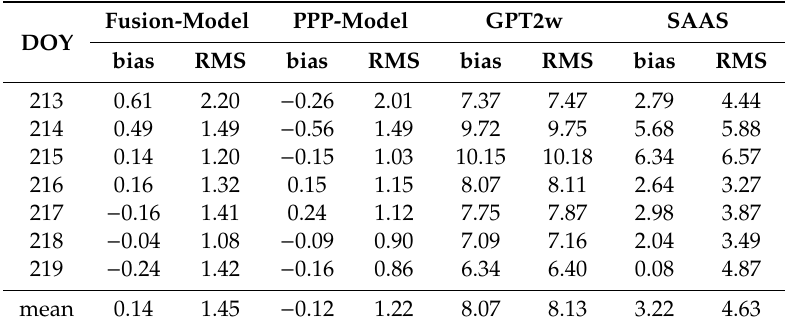
Table 4. Daily mean precision (cm) of troposphere models in August. DOY